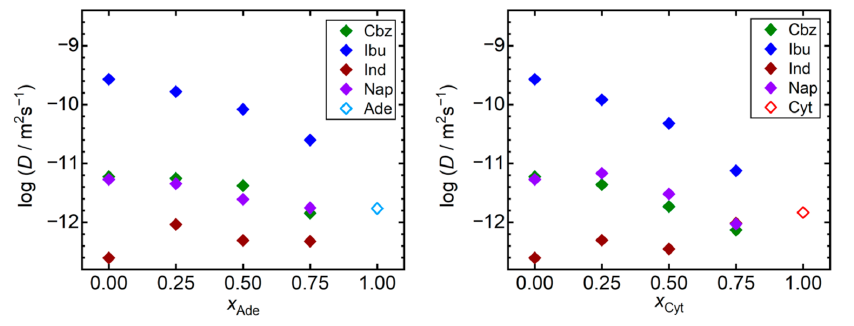
Figure 3. Self-diffusivities ( D ) of API molecules at 410 K (full symbols) and nucleobases (empty symbols) in the liquid. Mixtures of nucleobases (adenine, Ade—left; and cytosine, Cyt—right) with API (carbamazepine, Cbz; RS-Ibuprofen, Ibu; Indomethacin, Ind; and naproxene, Nap) are characterized by the molar fraction of the nucleobases ( x Ade , x Cyt ). Data are shown on the